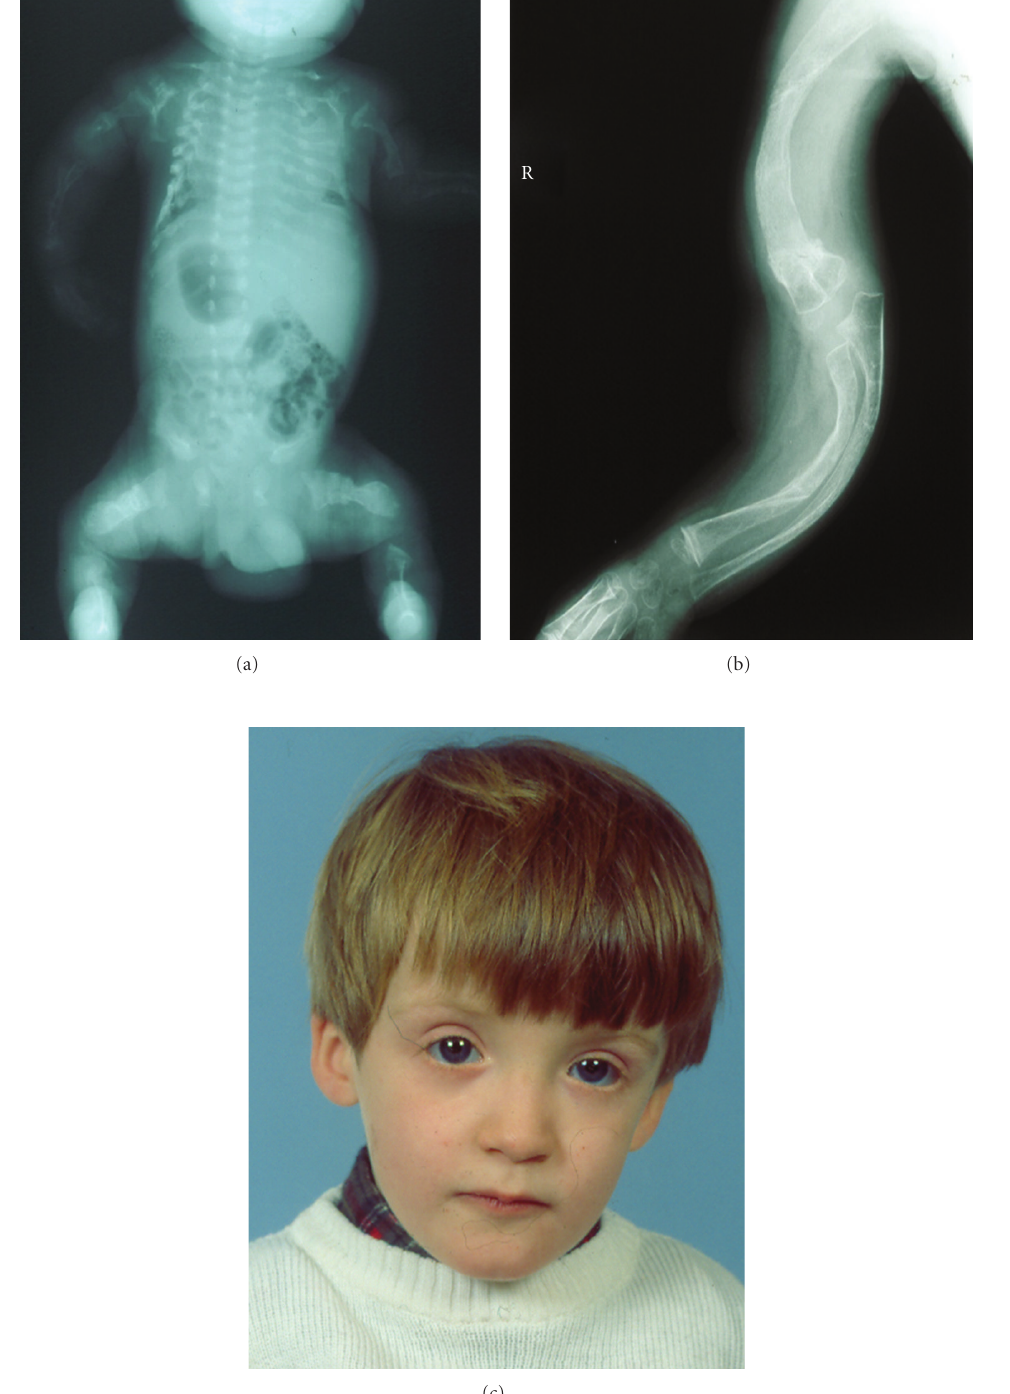
Figure 2: Clinical features of osteogenesis imperfecta. Osteopenia and multiple fractures (a), bone deformities (b) and blue sclerae (c).